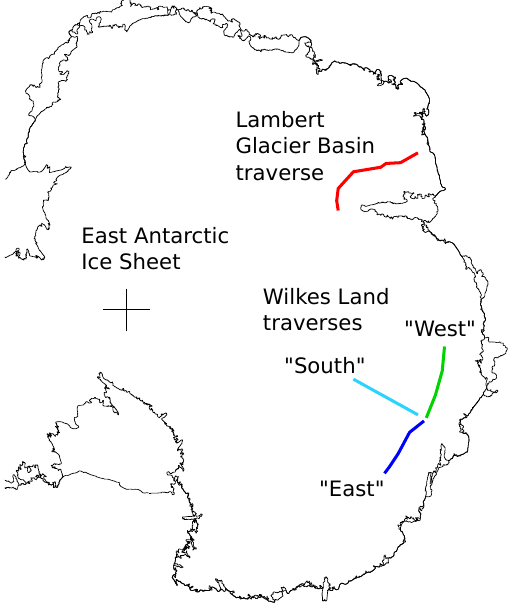
Figure 1: Australian traverse routes for measuring SMB using snow stakes.